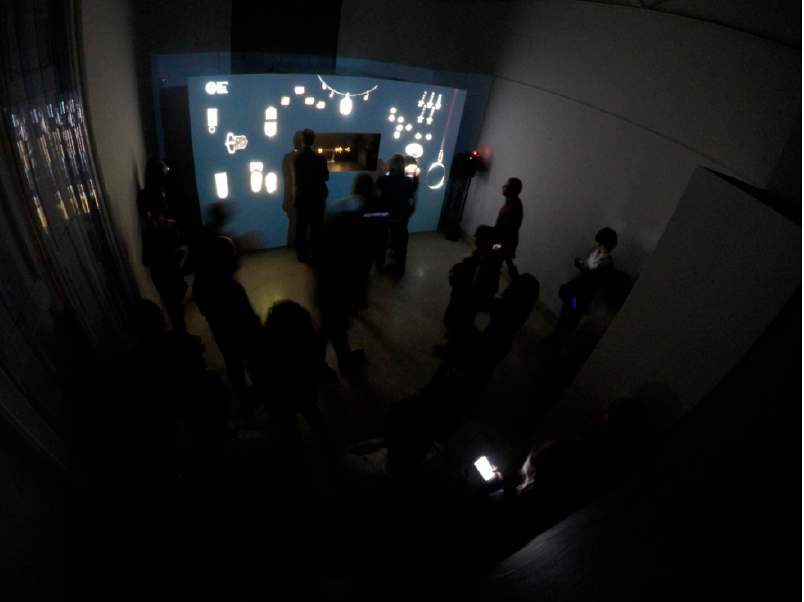
Figure 11. Holographic showcase integrated in a projection wall, CEMEC project, CNR ITABC and E.V.O.CA., 2017, National Hungarian Museum (NHM) of Budapest.